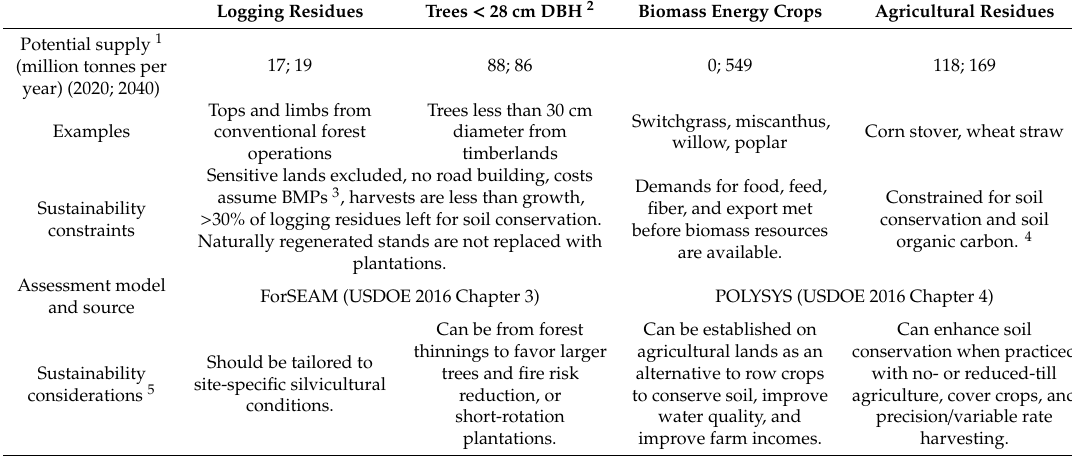
Table 1. Biomass feedstock supplies, sustainability attributes, and models and sources of the feedstocks used in this